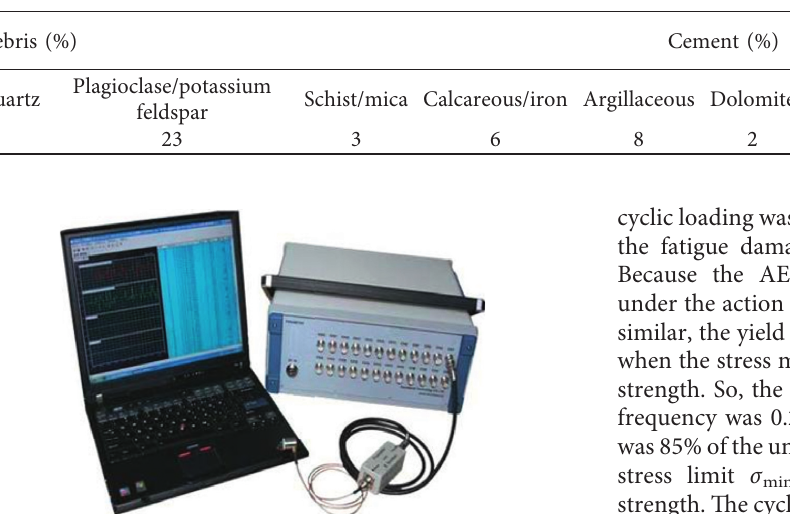
Table 1: Sand rock composition.